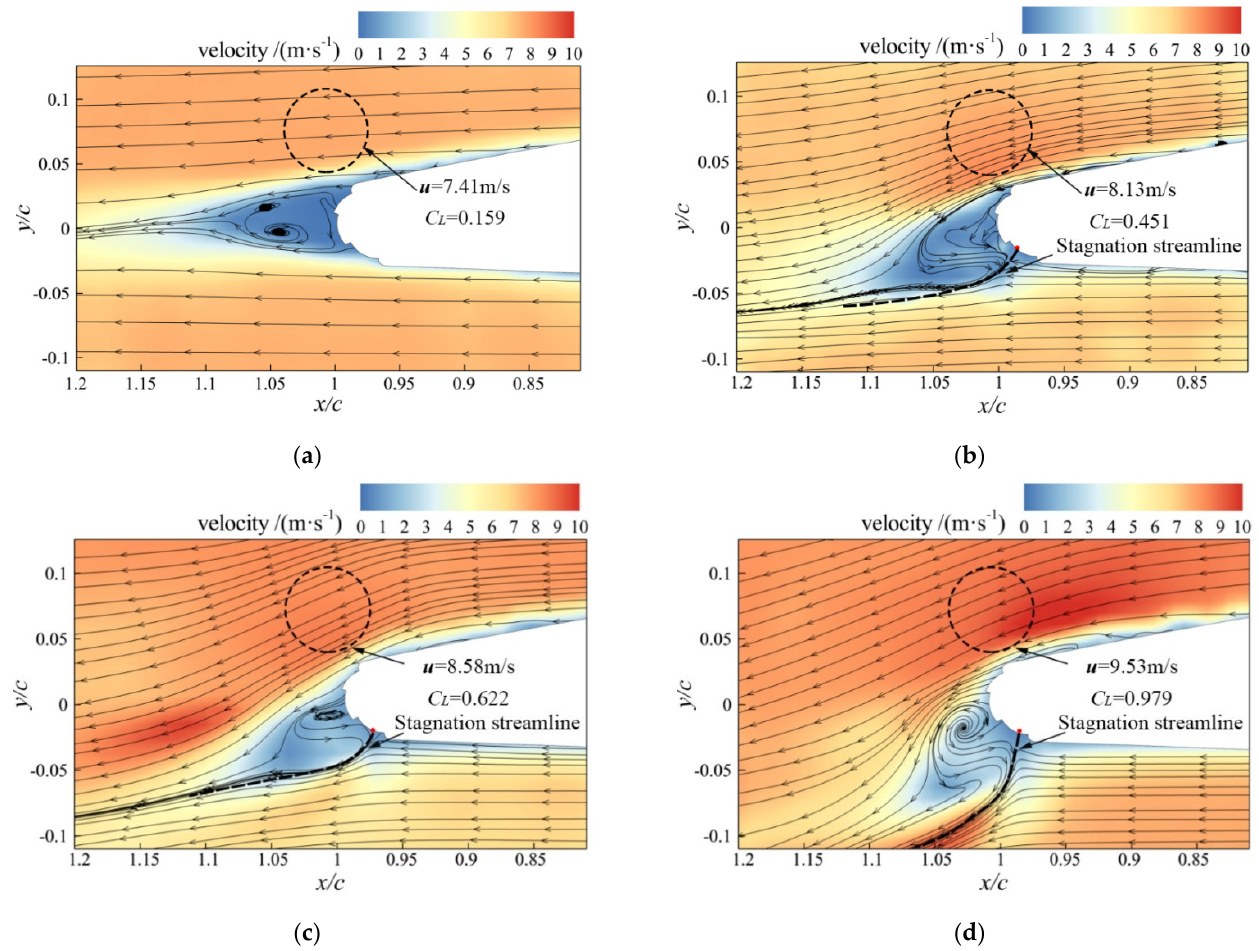
Figure 14. Comparison of velocity cloud and streamline diagrams at different blowing coefficients ( U ∞ = 8 m/s, AOA = 0°). ( a ) No Blowing. ( b ) C μ-Slot. 1 = C μ-Slot. 2 = C μ-Slot. 3 = 0.03. ( c ) C μ-Slot. 1 = C μ-Slot. 2 = C μ-Slot. 3 = 0.05. ( d ) C μ-Slot. 1 = C μ-Slot. 2 = C μ-Slot. 3 = 0.1.